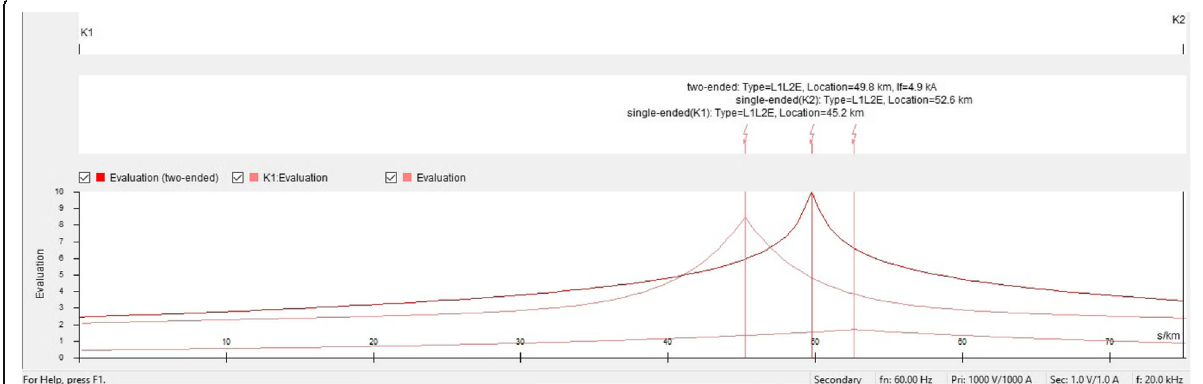
Fig. 9 Fault location based on the proposed